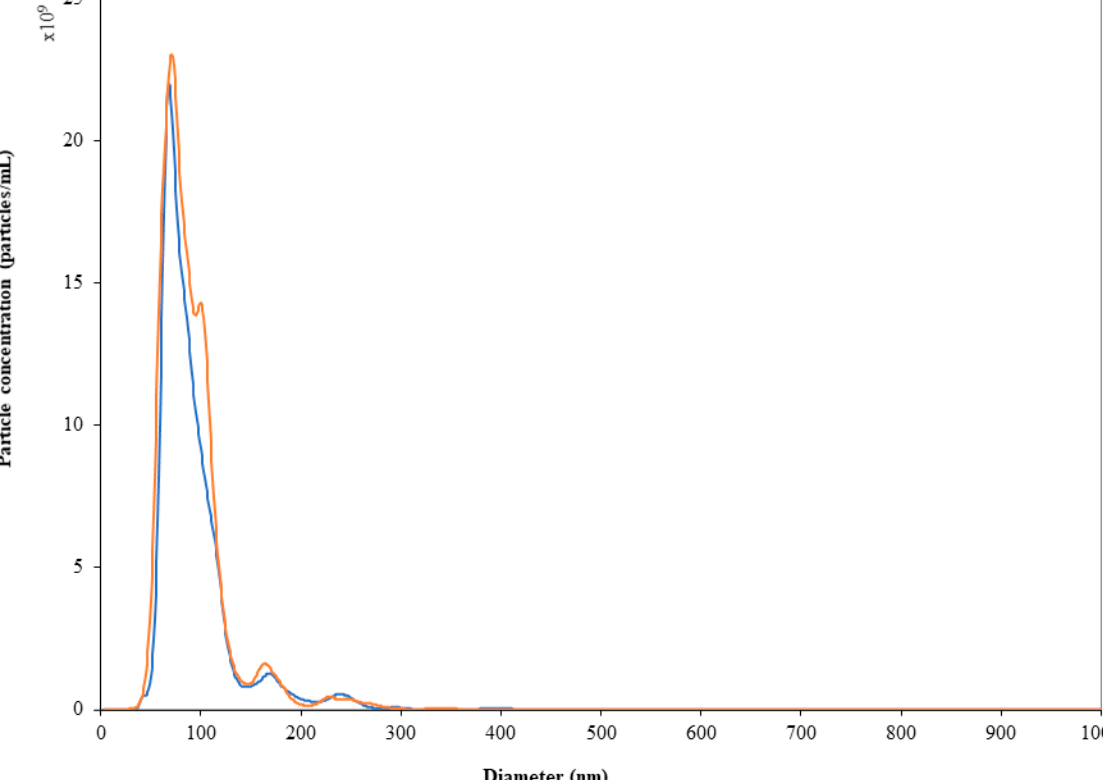
Figure 3. Particle size distribution registered by NTA for vial leftover which underwent (blue line) or not (orange line) road transportation. Any significant variations in particle distribution can be ascribed to the road transportation of vial leftover.